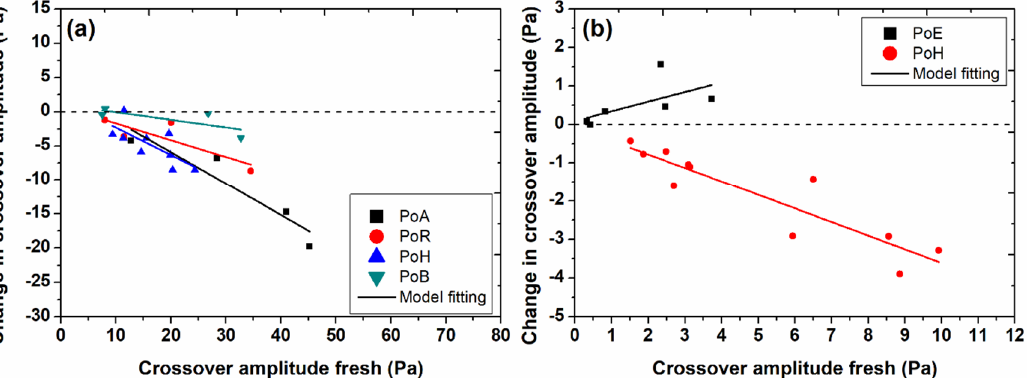
Figure 4. Change in crossover amplitude (degraded–fresh) as a function of crossover amplitude of fresh mud samples ( a ) from different ports and ( b ) from PoE and fluid mud samples from PoH. The dashed line represents the value where the degraded and fresh mud samples have the same crossover amplitude. The solid line represents the empirical fitting using Equation (1). (cid:3031)(cid:3032)(cid:3034)(cid:3045)(cid:3028)(cid:3031)(cid:3032)(cid:3031) – (cid:3033)(cid:3045)(cid:3032)(cid:3046)(cid:3035) × 100(cid:4673) after organic The percent change in crossover amplitude (cid:4672) (cid:3033)(cid:3045)(cid:3032)(cid:3046)(cid:3035)